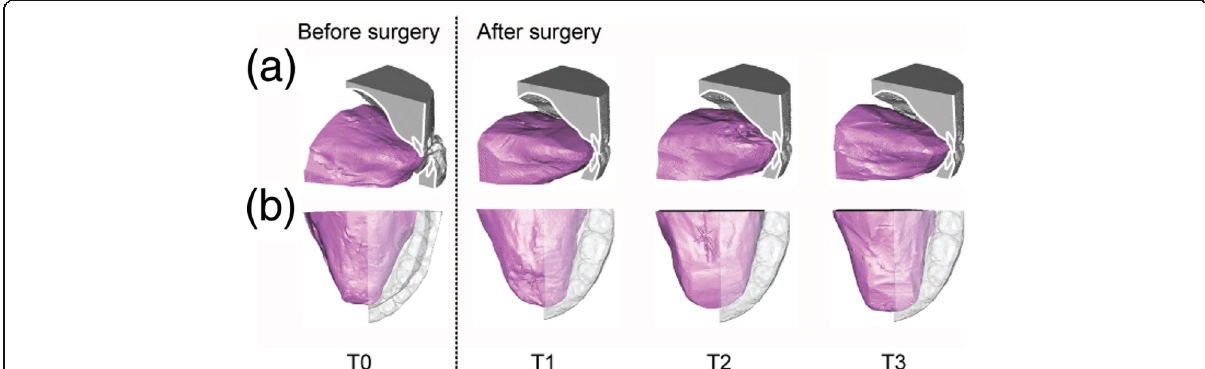
Fig. 4 3D images of the half model reconstructed from the DICOM data of VPS impression pattern. The changes in the overjet value and the morphological and positional changes of the tongue inside the oral cavity at the time points T0, T1, T2, and T3 from two different 3D images views. a Oblique lateral view. b Upper occlusal view